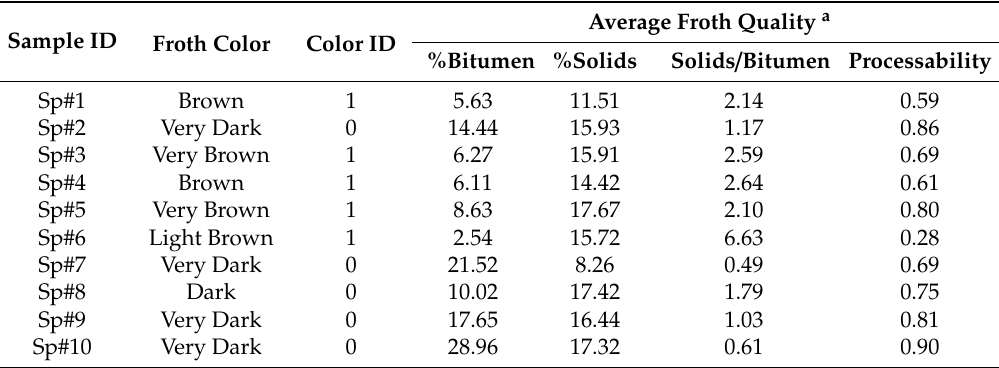
Table 2. Observed and measured froth